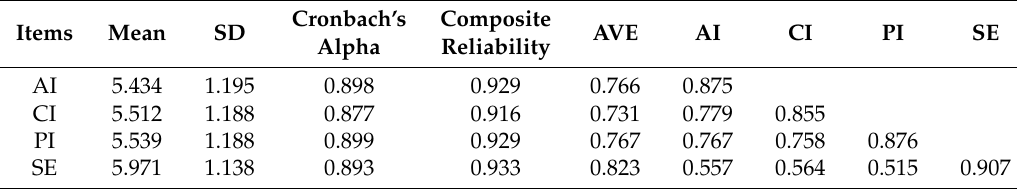
Table 4. Reliability and validity (strong